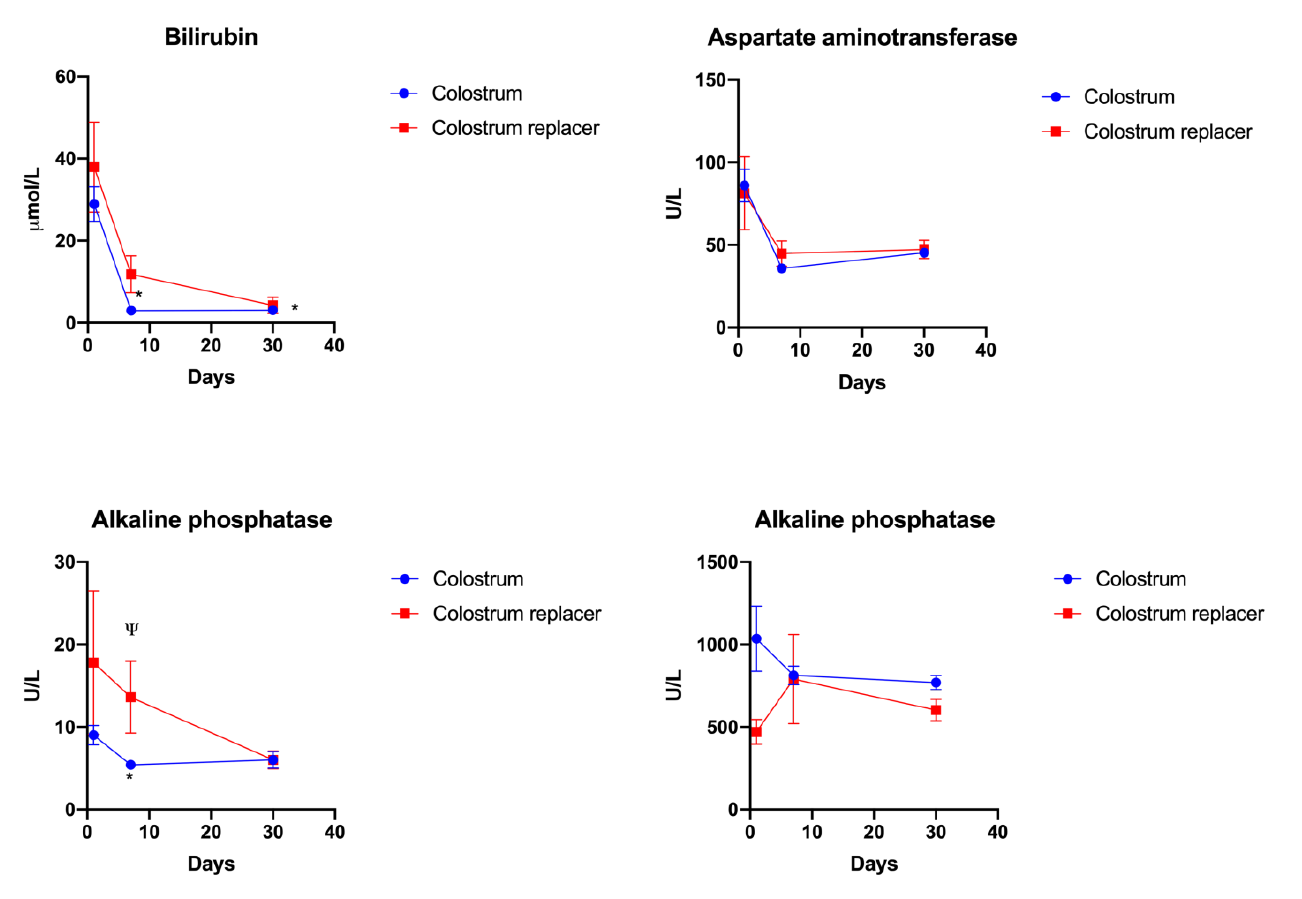
Figure 7. The effect of administration of colostrum or colostrum replacer on major liver markers in calves. The experimental animals ( n = 5 of each group) received colostrum or artificial colostrum replacement for the first 6 h after birth. On days 1, 7 and 30, the venous blood was collected and analyzed. The results are shown as mean ± SEM from five experimental animals. *—denotes significant changes between time points of the same group ( p < 0.05). Ψ – p < 0.05 indicates significance between experimental groups.